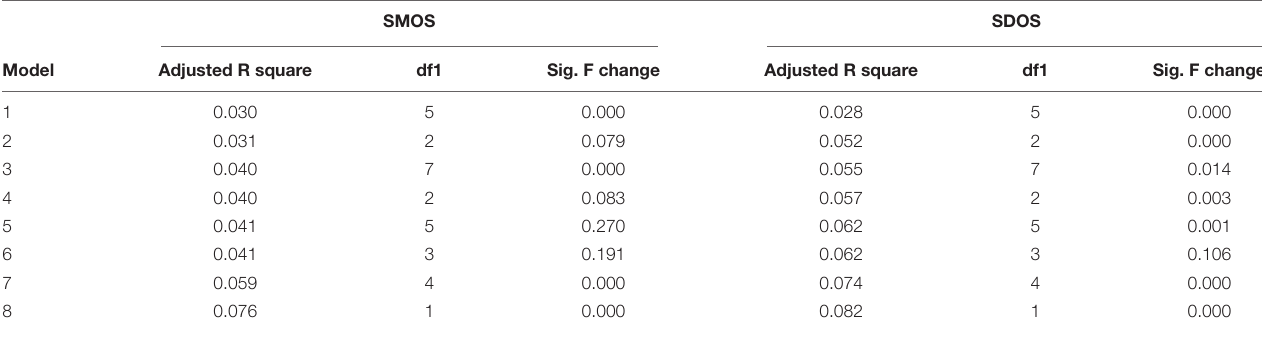
TABLE 3 | Model fit change in hierarchical linear modeling.